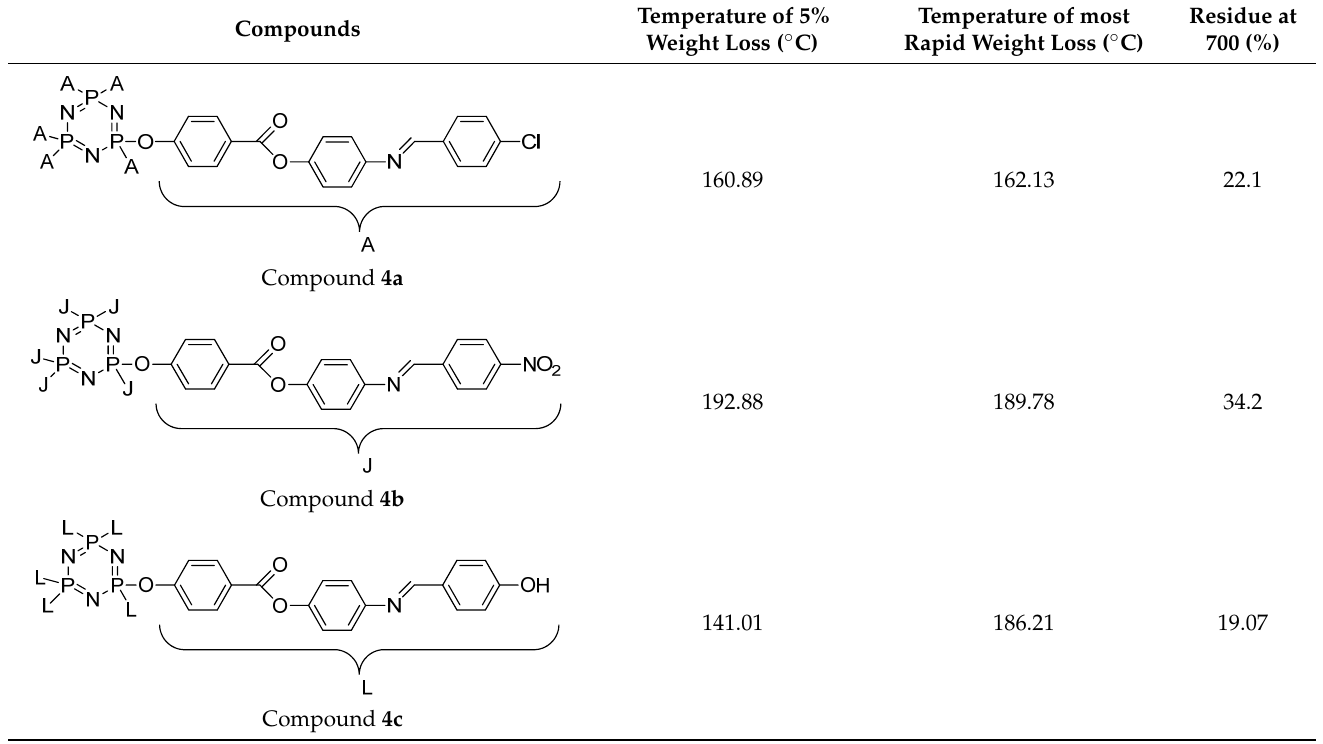
Table 3. LOI value of the